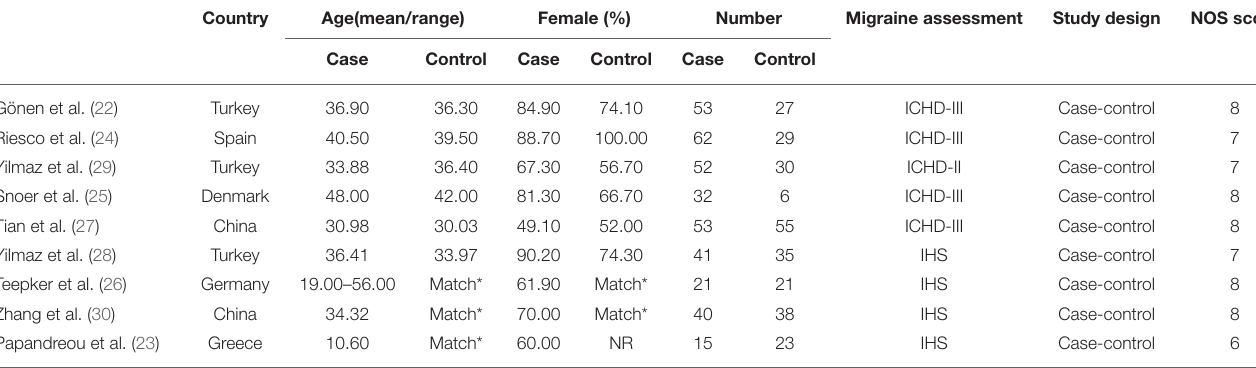
TABLE 1 | Characteristics of included studies.